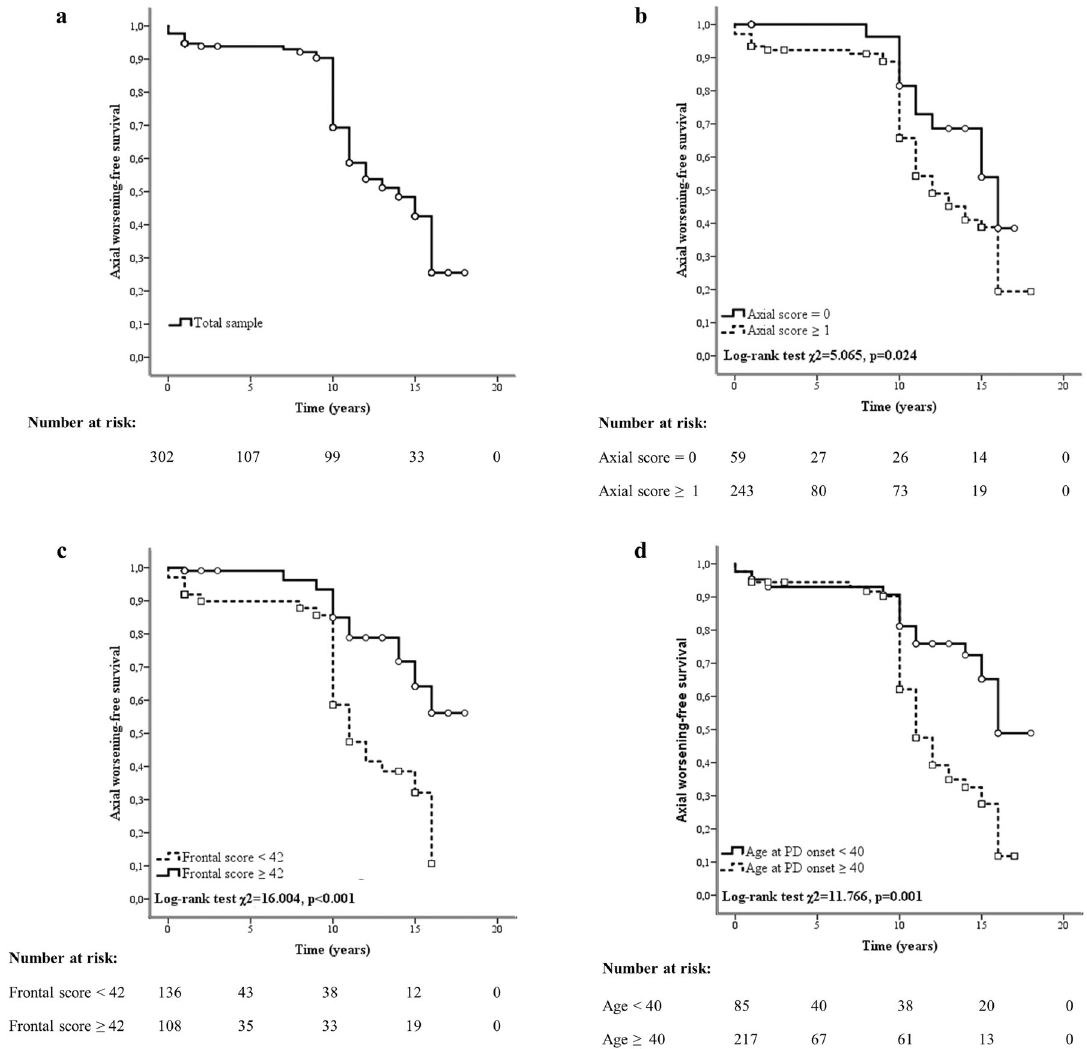
Fig. 2 Risk factors for axial impairment progression in people with Parkinson ’ s disease and subthalamic deep brain stimulation. Kaplan – Meier curves show axial impairment progression in the total sample ( a ) and subgroups of people with Parkinson ’ s disease (PD) and subthalamic deep brain stimulation based on preoperative axial scores ( b ), frontal scores ( c ), and age at disease onset ( d ). The “ axial worsening-free survival ” re fl ects axial impairment progression intended as the achievement of an axial score ≥ 7. Squares and circles in the Kaplan – Meier curves indicate censored